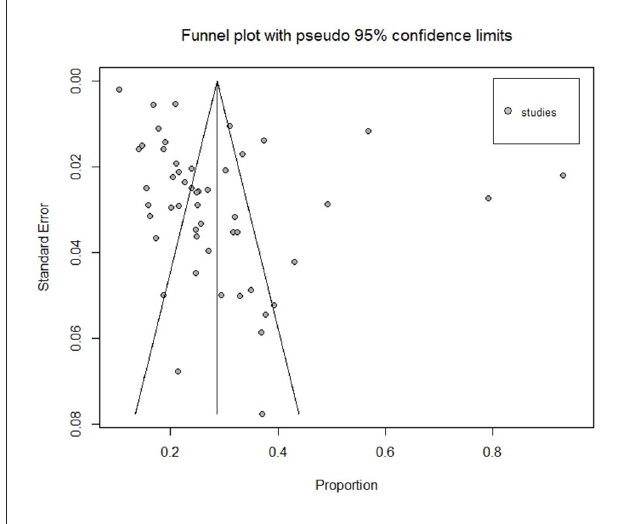
FIGURE4 A bias assessment funnel plot of all included studies reporting HBV prevalence in